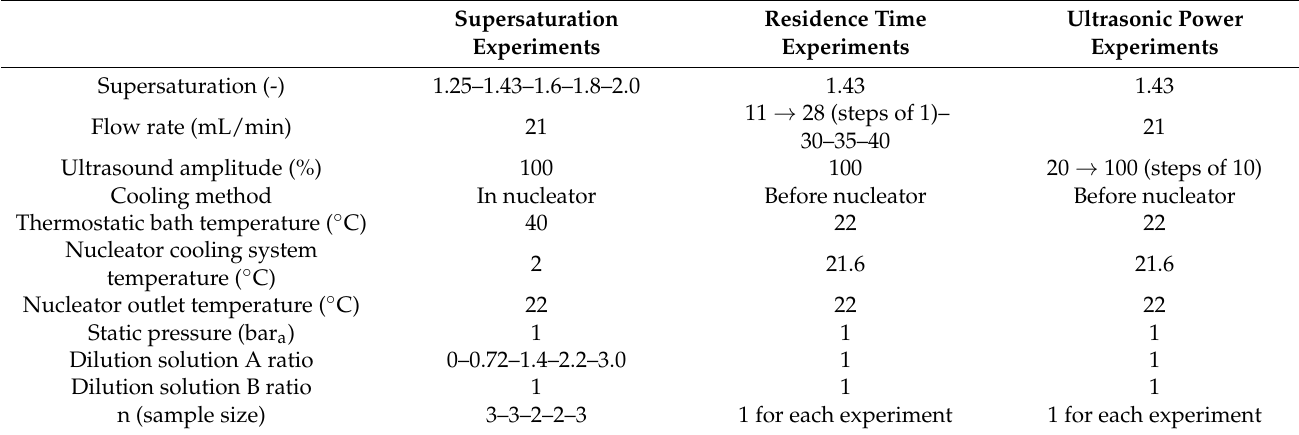
Table 2. Experimental setup for the evaluation of the nucleation rate in an ultrasonic nucleator. The dilution ratio and the sample size for the supersaturation experiments correspond with their respective supersaturation experiment.